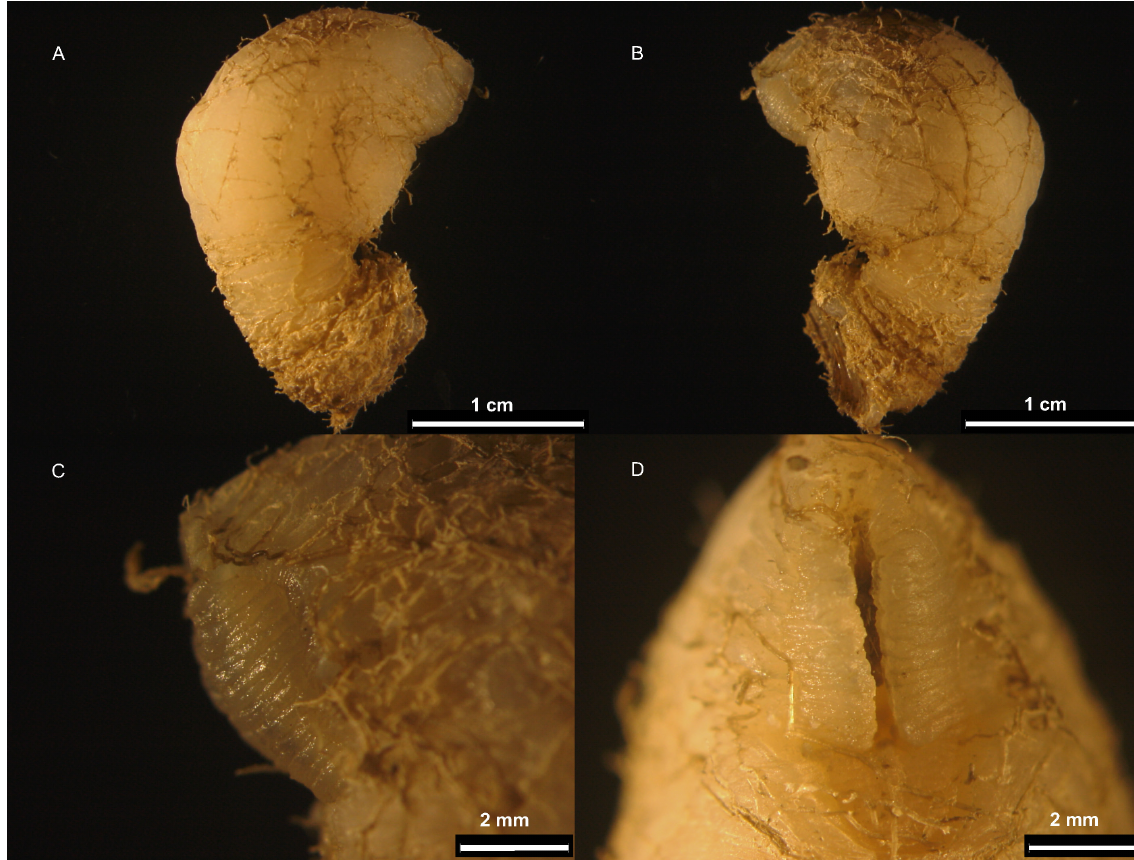
Fig. 2. External morphology of Heteralepas gettysburgensis sp. nov. (holotype) A–B . Side views showing the capitulum and peduncle. C . Side view of the aperture. D . Front view of the